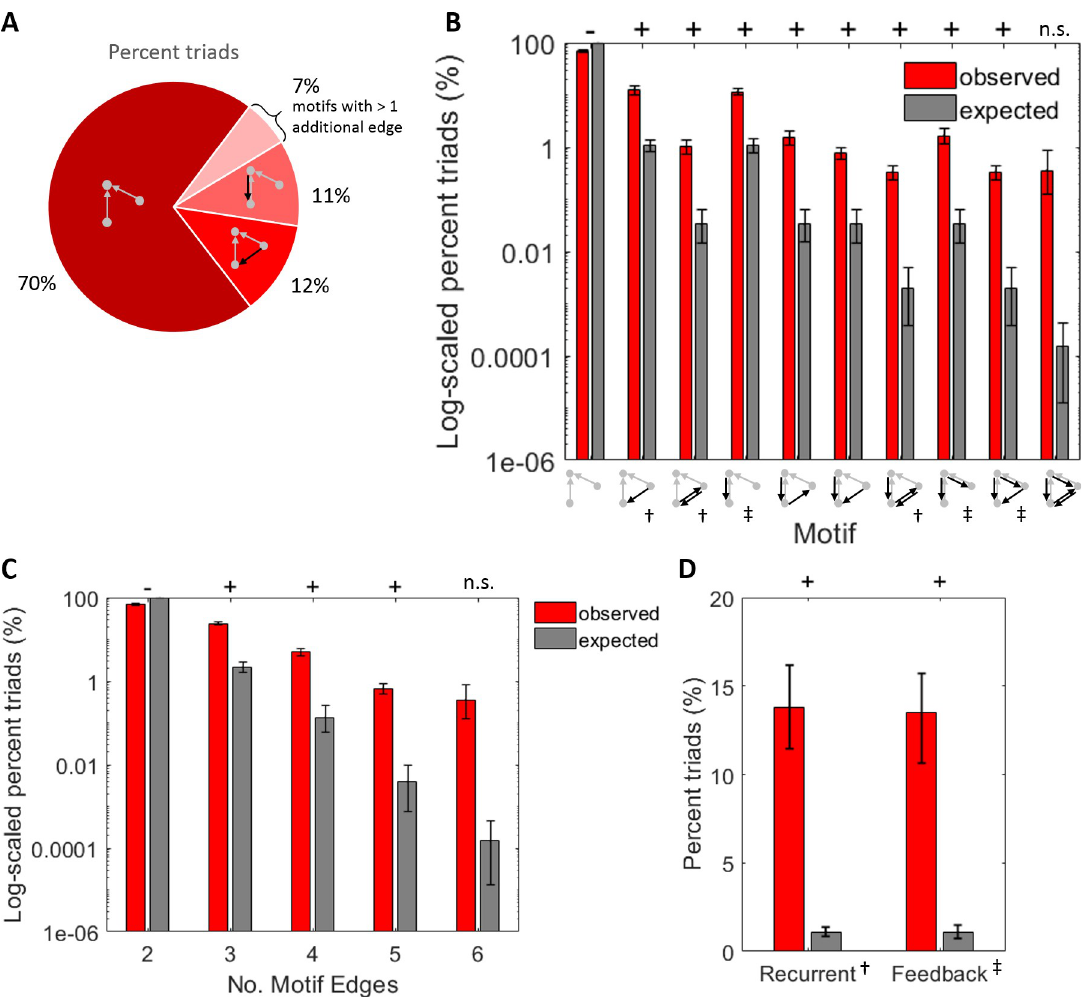
Fig 9. Recurrent and feedback motifs were rare but occurred more than expected given the network-wide edge density. (A) Percent of network triads accounted for by each motif type. Motifs with greater edge density were more rare. Values indicate means across all networks. (B) Log 10 scaled observed percentages of triads compared to expected percentages of triads per motif. Expected percentages obtained by raising the probability of observing a connection to the power of the number of edges in the motif, for each network. (C) Log 10 scaled observed and expected percentages of triads in (B), grouped by the number of edges they contain. (D) Linearly scaled observed and expected percentages of triads in (A), grouped by the number of recurrent and feedback edges they contain. Significance indicators: ‘+’ indicates significantly more than expected and ‘-’ indicates significantly less than expected. For all significant values, p < 1x10 -6 . Motif indicator: † Recurrent, ‡